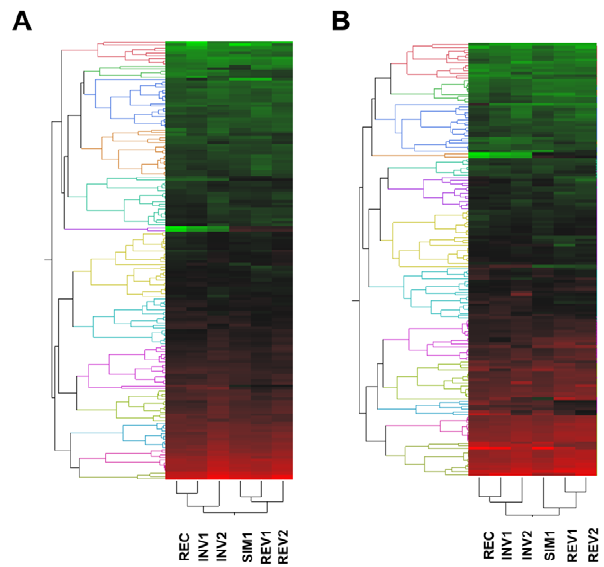
Figure 4. Two-way hierarchical clustering of the average levels of expression estimated for the 1% transcripts exhibiting the lowest P values across the six strains under study according to one-way ANOVA. (A) Males; (B) females. For both sexes, the patterns of expression among red-eyed strains, i.e. those with (INV1, INV2) or without (REC) the disrupted ultraconserved region CG15121–CG16894 , are more similar to each other than either of them is to any of the white-eyed strains (SIM1, REV1, REV2), all of them carrying the ultraconserved region in intact condition. Thirty-six one-color hybrid- izations were performed involving three biological replicates for each sex-by-strain combination. Red, high expression; green, low expression.